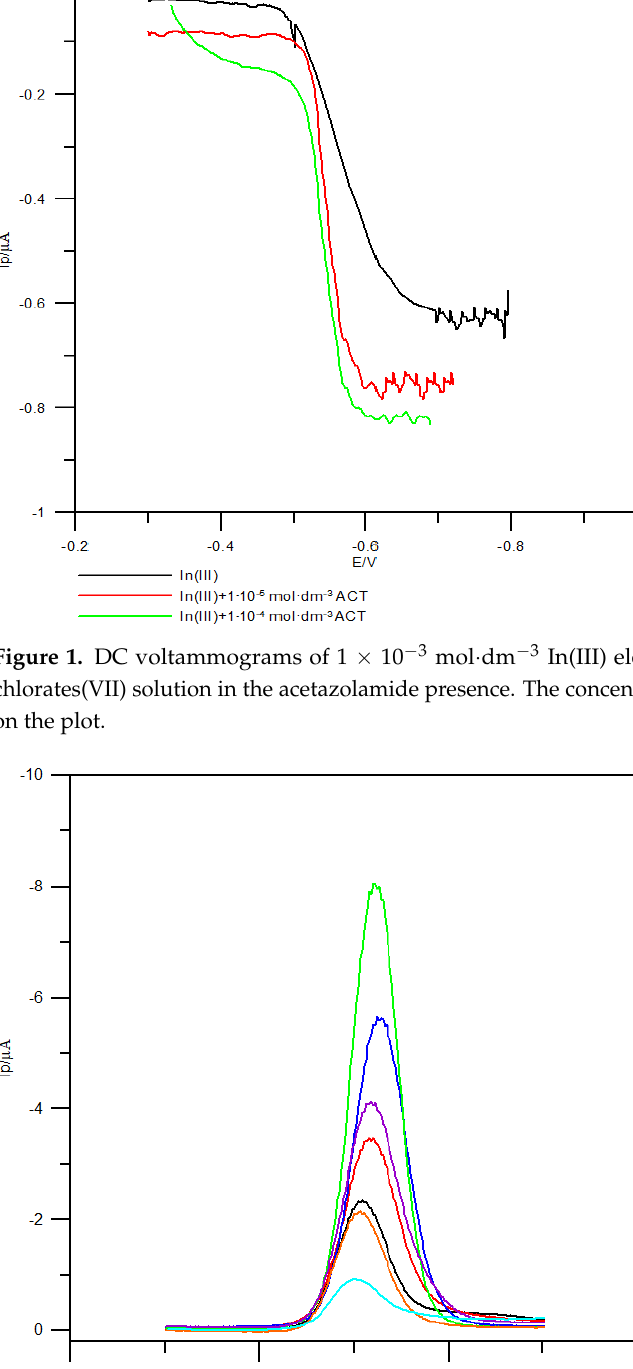
Figure 1. DC voltammograms of 1 × 10 − 3 mol · dm − 3 In(III) electroreduction in 1 the mol · dm − 3 chlorates(VII) solution in the acetazolamide presence. The concentrations of acetazola- mide are given on the plot.